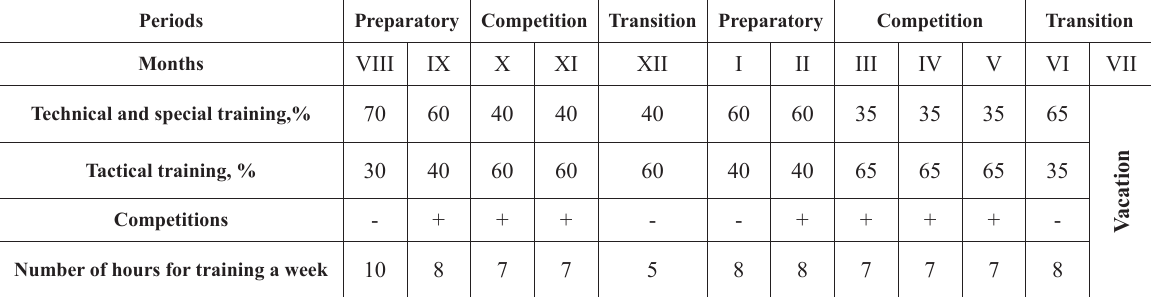
Table 1. Annual training plan for junior group